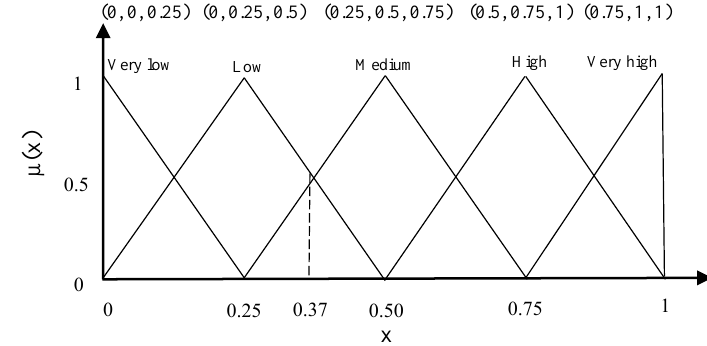
Figure 4. Membership functions of linguistic values